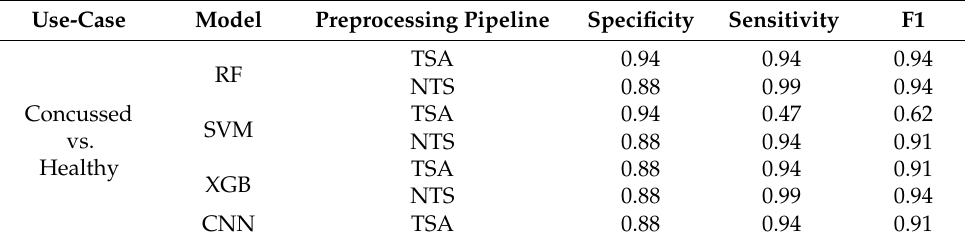
Table 1. Classification performance (sensitivity, specificity, F1) of four different ML models and two different data preprocessing pipelines for binary prediction of “healthy” vs. “concussion”. The testing dataset ( n = 34) classes were representative of the training set distribution (Healthy = 17, Concussed =